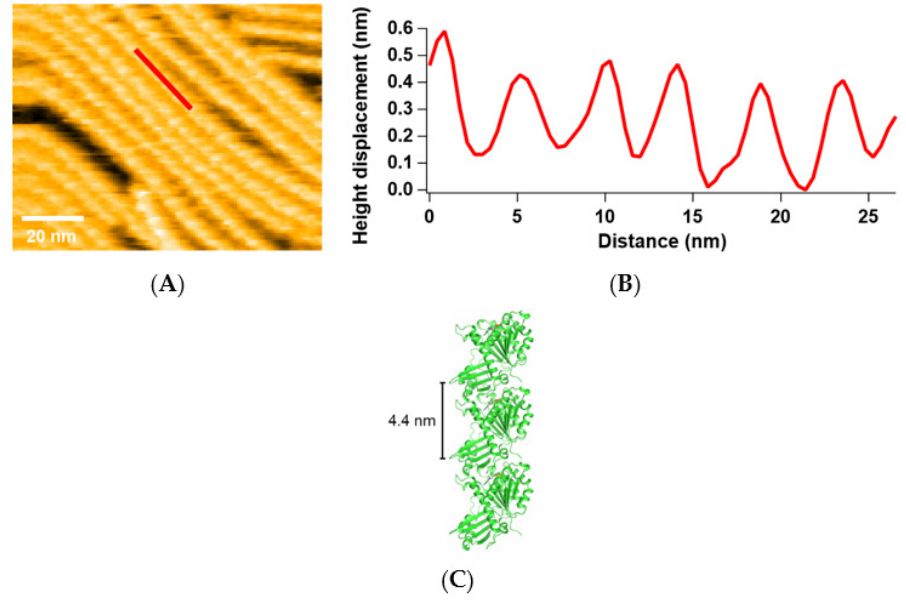
Figure 1. SaFtsZ filaments observed by HS-AFM: ( A ) An image of FtsZt filaments in the presence of 200 nM FtsZt and 600 μ M GTP; ( B ) Line profile of height displacement along the red-line in ( A ); ( C ) Filamentous structure of SaFtsZ in the crystal (PDB entry: 3VOA).